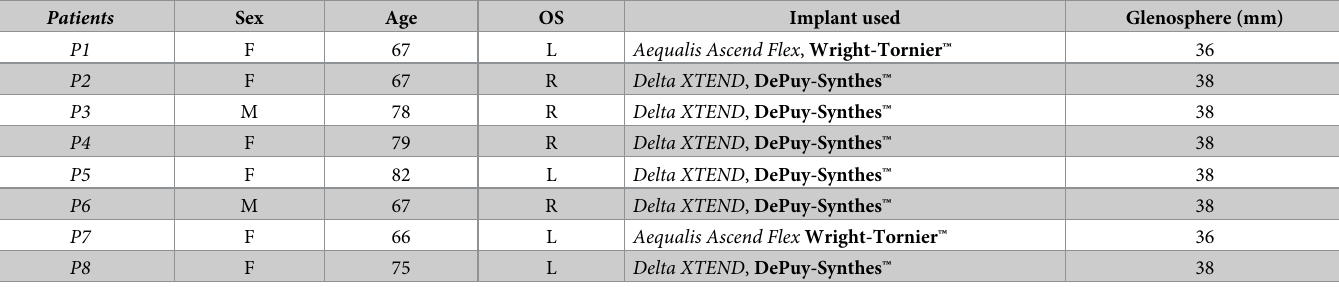
Table 1. Patient